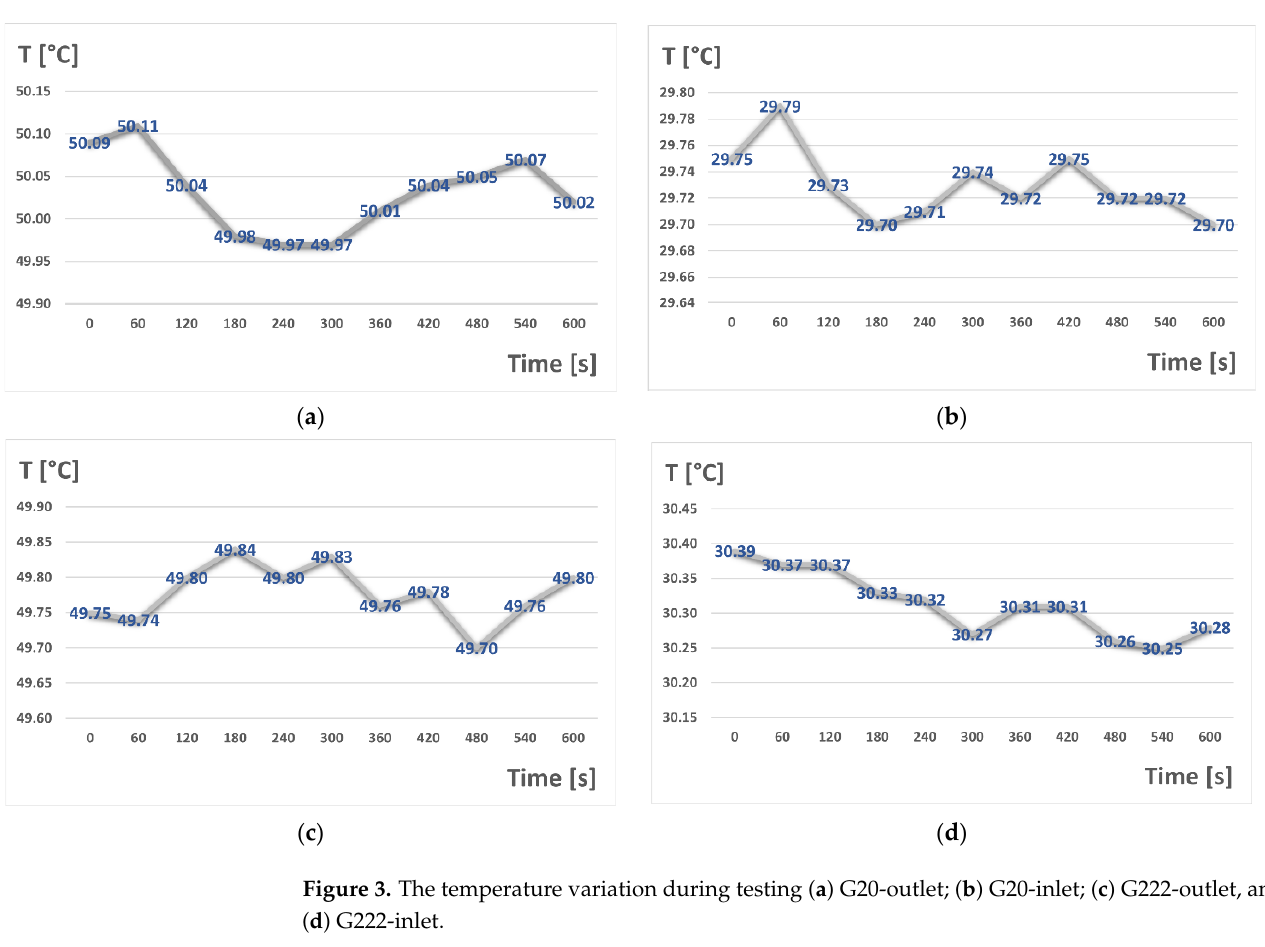
Table 7. Performance indicators for the 50/30 °C condensation regime.